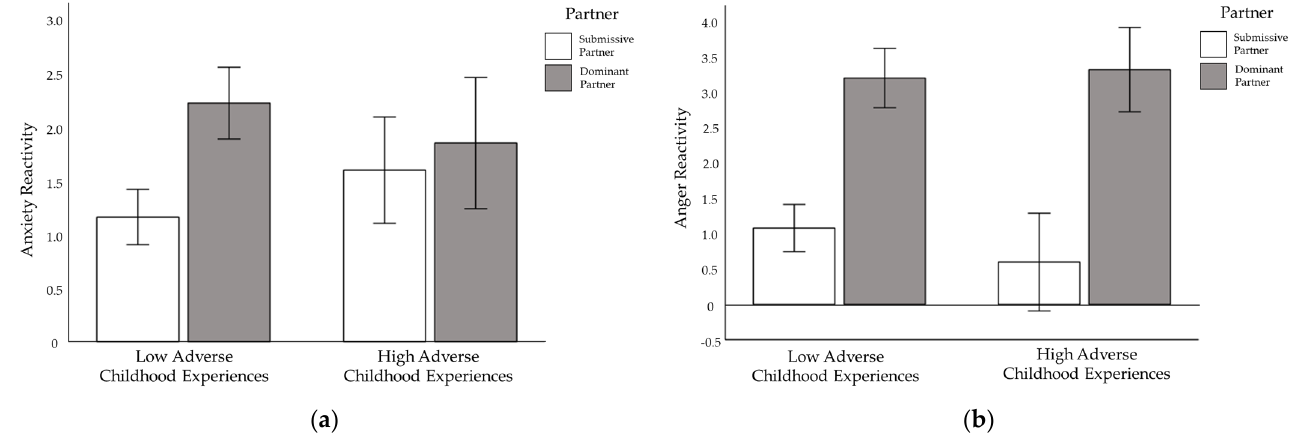
Figure 3. The Interaction of Early Adverse Experiences and Partner Behavior on ( a ) Anxiety Reactivity and ( b ) Anger Reactivity. Note. Bars represent 1 standard error.